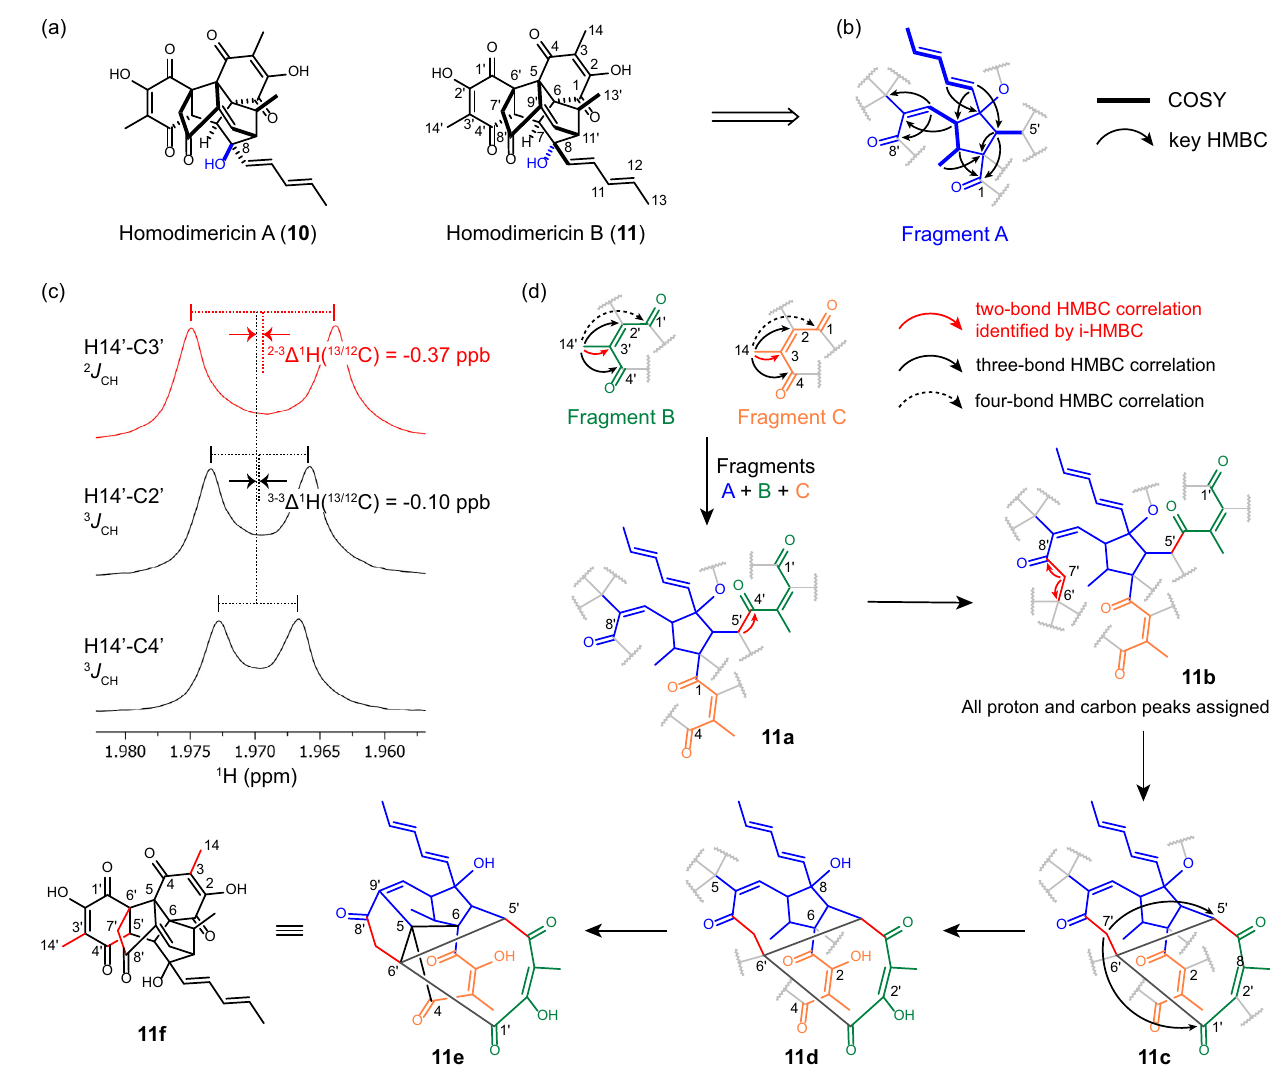
Fig.5|StructureelucidationofhomodimericinB( 11 )usingi-HMBC.a Structures of homodimericins A ( 10 ) and B ( 11 ) with stereocon fi guration difference indicated in blue; b fragment A was the only segment that could be solved using the